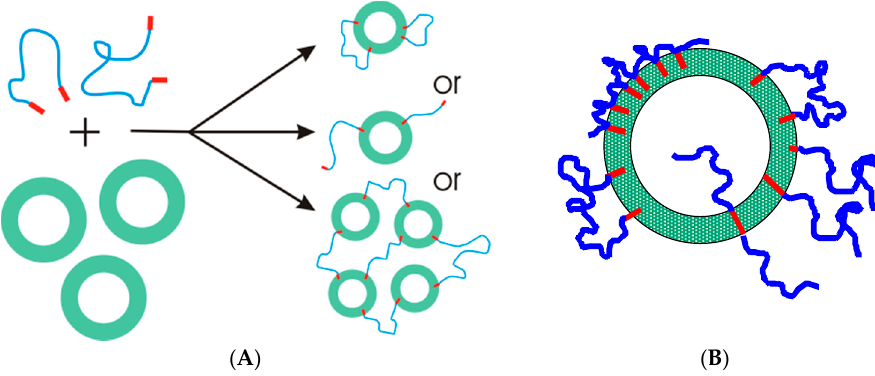
Figure 11. Schematic representation of the ( A ) association of telechelic polymers and vesicles leading to the formation of decorated vesicles and vesicle networks; and ( B ) anchoring of hydrophobically modified polymers of different architectures to vesicle membranes.